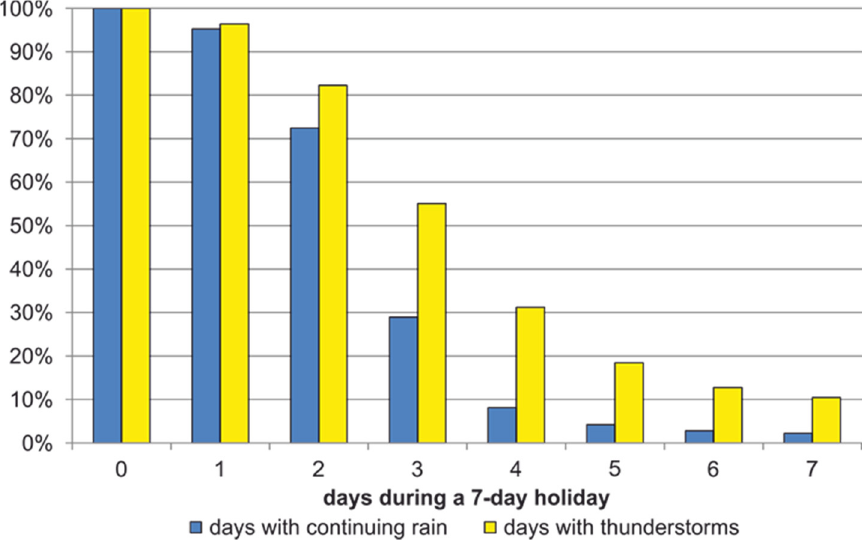
Figure 2. The acceptable number of days with rain during a 7-day holiday.